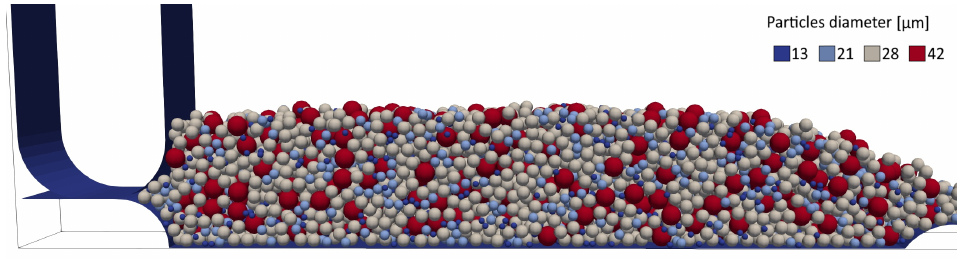
Figure 4. State of the powder feedstock after the settling of the